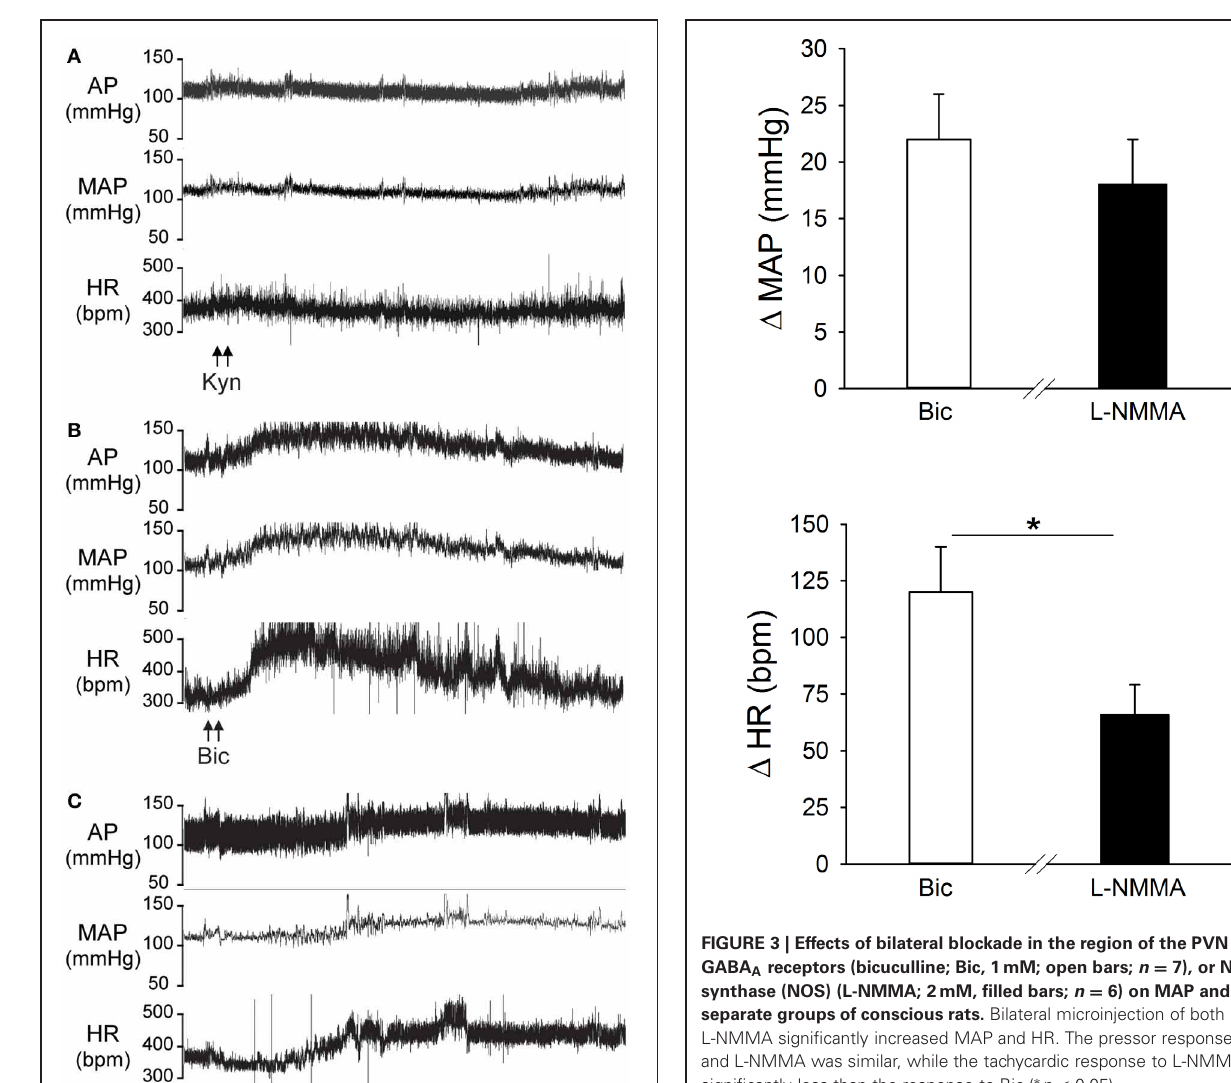
these studies in that anesthesia is well-known to alter neuro-